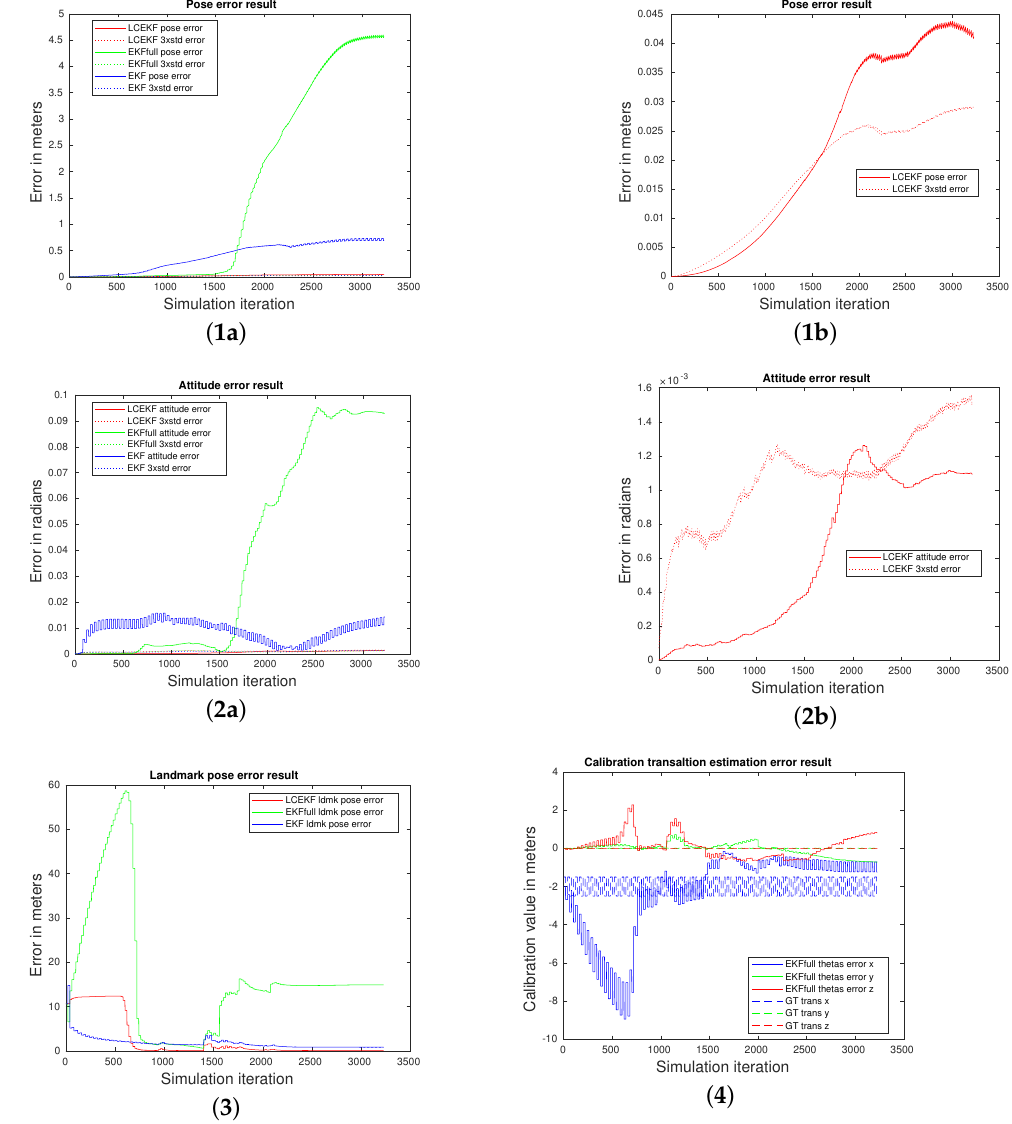
Figure 10. SLAM with high amplitude periodic noise (Case v): methods’ comparison. Figures ( 1a ) and ( 2a ) represent the MSE of the pose and attitude estimation over 100 executions for the three methods. The LCEKF results without the EKF and EKFfull are presented in Figures ( 1b ) and ( 2b ). Full lines are the mean of the estimation, and dotted lines represent the 3 sigma value. Figure ( 3 ) represents the MSE of the landmark convergence during the simulation. Figure ( 4 ) shows the EKFfull calibration parameters’